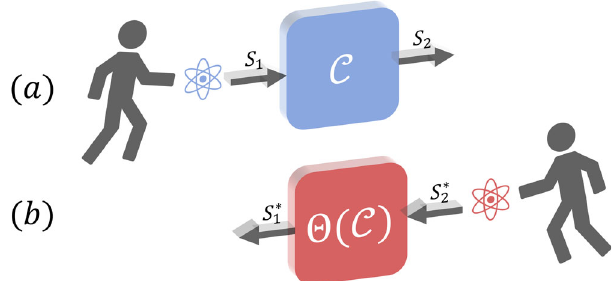
Fig. 1 Bidirectional devices. A bidirectional device is in principle compatible with two alternative modes of operation. In the forward mode ( a ), an agent prepares an input system at time t 1 and obtains an output system at time t ≥ t 2 1 . In the backward mode ( b ), a hypothetical agent could prepare an input at time t 2 and obtain an output at time t 1 . These two modes of using the device correspond to two different input-output transformations C and Θ ð C Þ ,